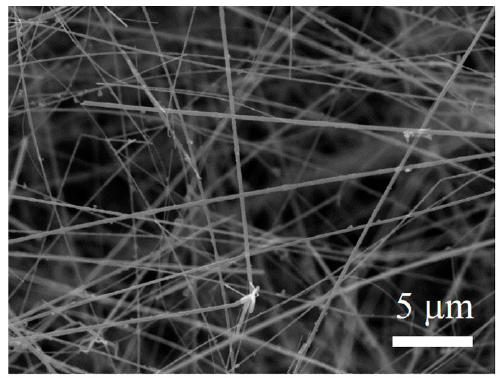
Figure 6. SEM images of the as-achieved products (firing at 1200 °C) after hydrofluoric acid (HF) treatment.